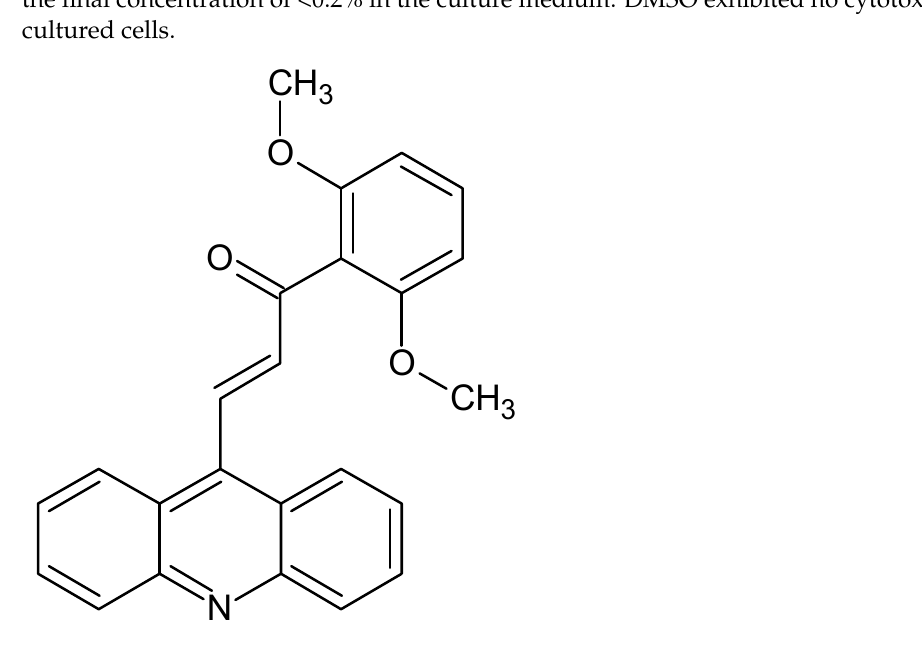
Cell lines A2058 (human melanoma lymph node metastasis, cat. 91100402) from